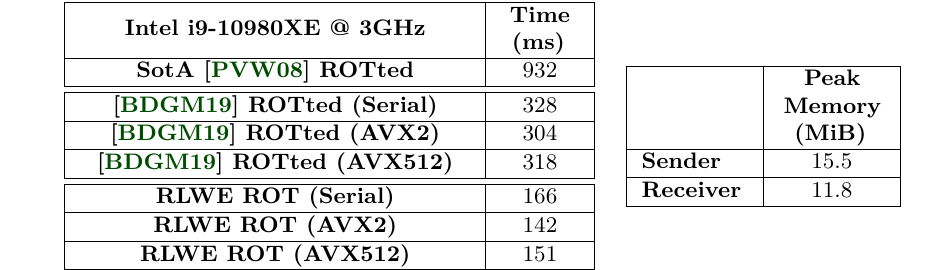
Figure 7: Speedup for the proposed ROT and [BDGM19] in all ARM devices. The ARM A7 architecture result for [BDGM19] is used as the baseline. Table 5: PSI peak memory for the x86_64